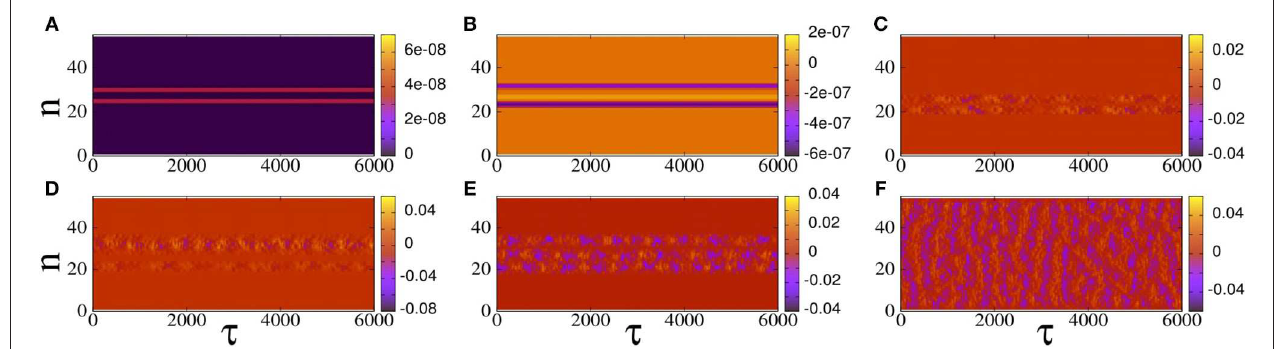
τ plane for β L − 0.10, (F) φ ac =